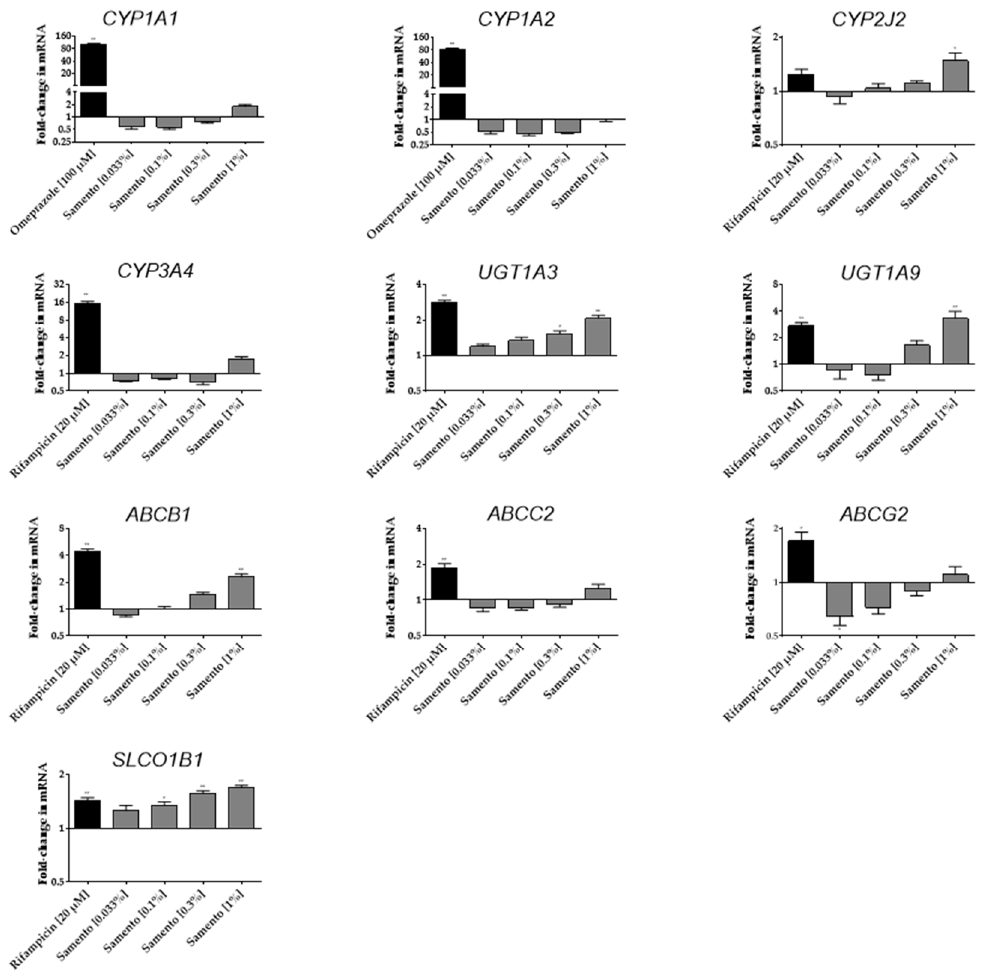
Figure 3. Influence of Samento on the mRNA expression of several drug metabolizing enzymes and drug transporters in LS180 cells. Cells were incubated for four days with different concentrations (0.033–1%) of Samento, or the positive controls rifampicin (20 µM) and omeprazole (100 µM), or medium alone (negative control). After harvesting, RNA extraction, and cDNA synthesis, mRNA was quantified by RT-PCR. Expression data were normalized to the housekeeping gene GU and to the negative control. Data are expressed as mean ± S.E.M. for n = 5 biological replicates. Data were analyzed using ANOVA with Dunnett’s post hoc test compared to the medium control. * p < 0.05, ** p < 0.01.